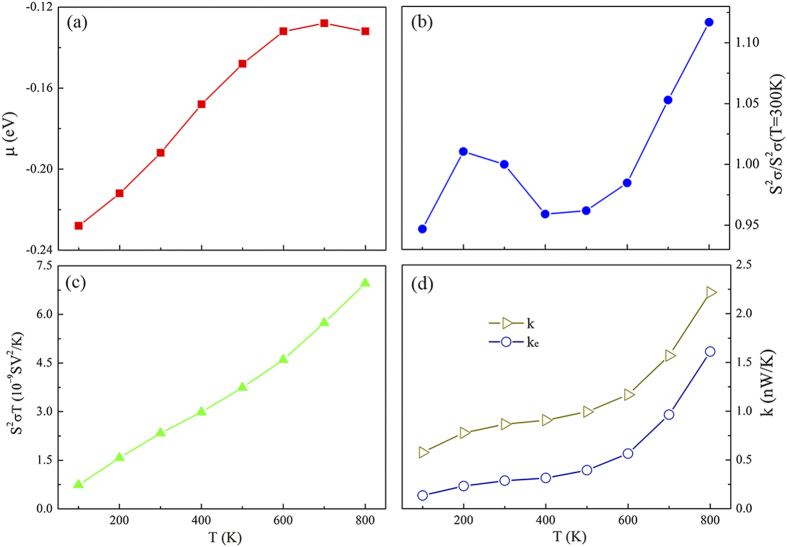
(a) , (b) , (c)  and (d) k, ke of MoS2/WS2 (N = 1) nanoribbons as a function of temperature T, corresponding to Max ZT in Fig. 2(b). The  is normalized by the  at T = 300 K, .